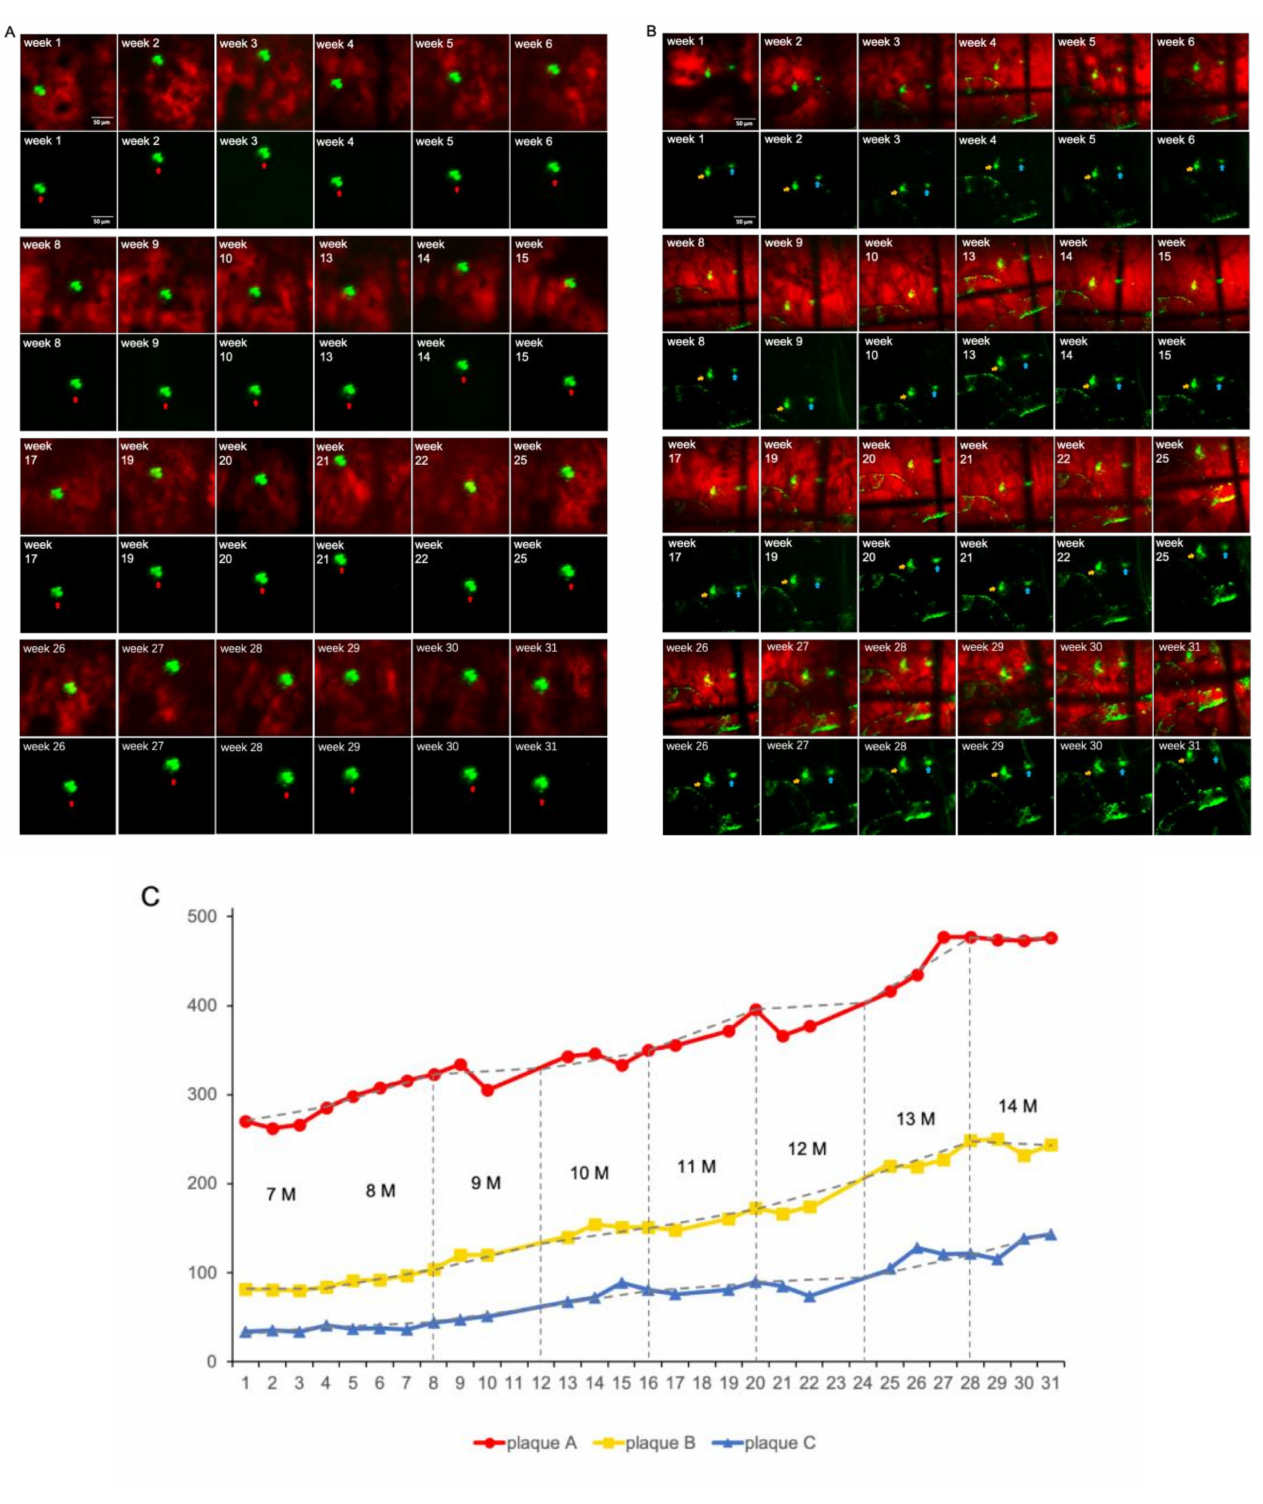
Figure 5. A β plaques grow over time: ( A ) Plaque A (red arrow) was imaged for up to 31 weeks. ( B ) Plaques B (yellow arrow) and C (blue arrow) were imaged for up to 31 weeks. Scale bar: 50 µ m. ( C ) Plaque A, B, C cross-sectional areas are shown over